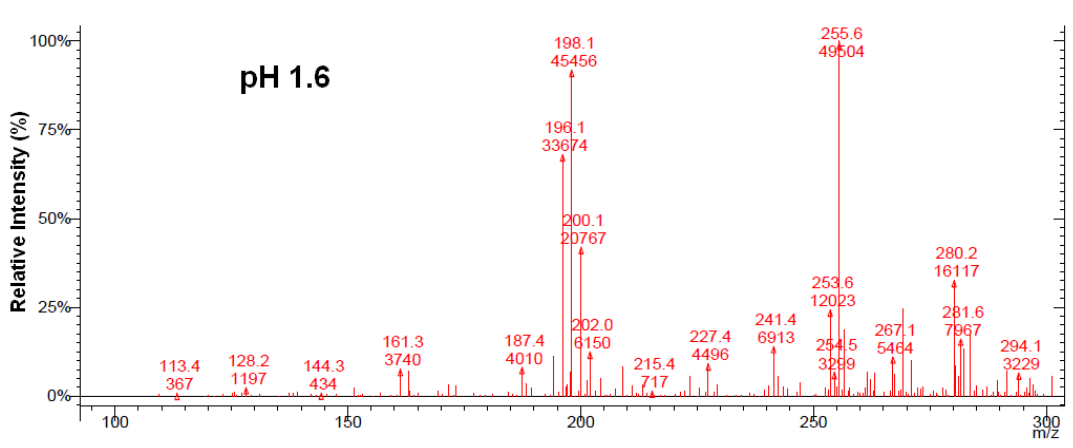
Fig. S3. Negative-ion ESI–MS spectrum for the complexes formed in the FeCl system at ligand-to-metal molar ratio 4:1, pH 1.6, C Explanation of the signal described in the text: m/z = 256.0 [Fe(III) + fragment ion m/z = 78 + 3Cl + OH] -